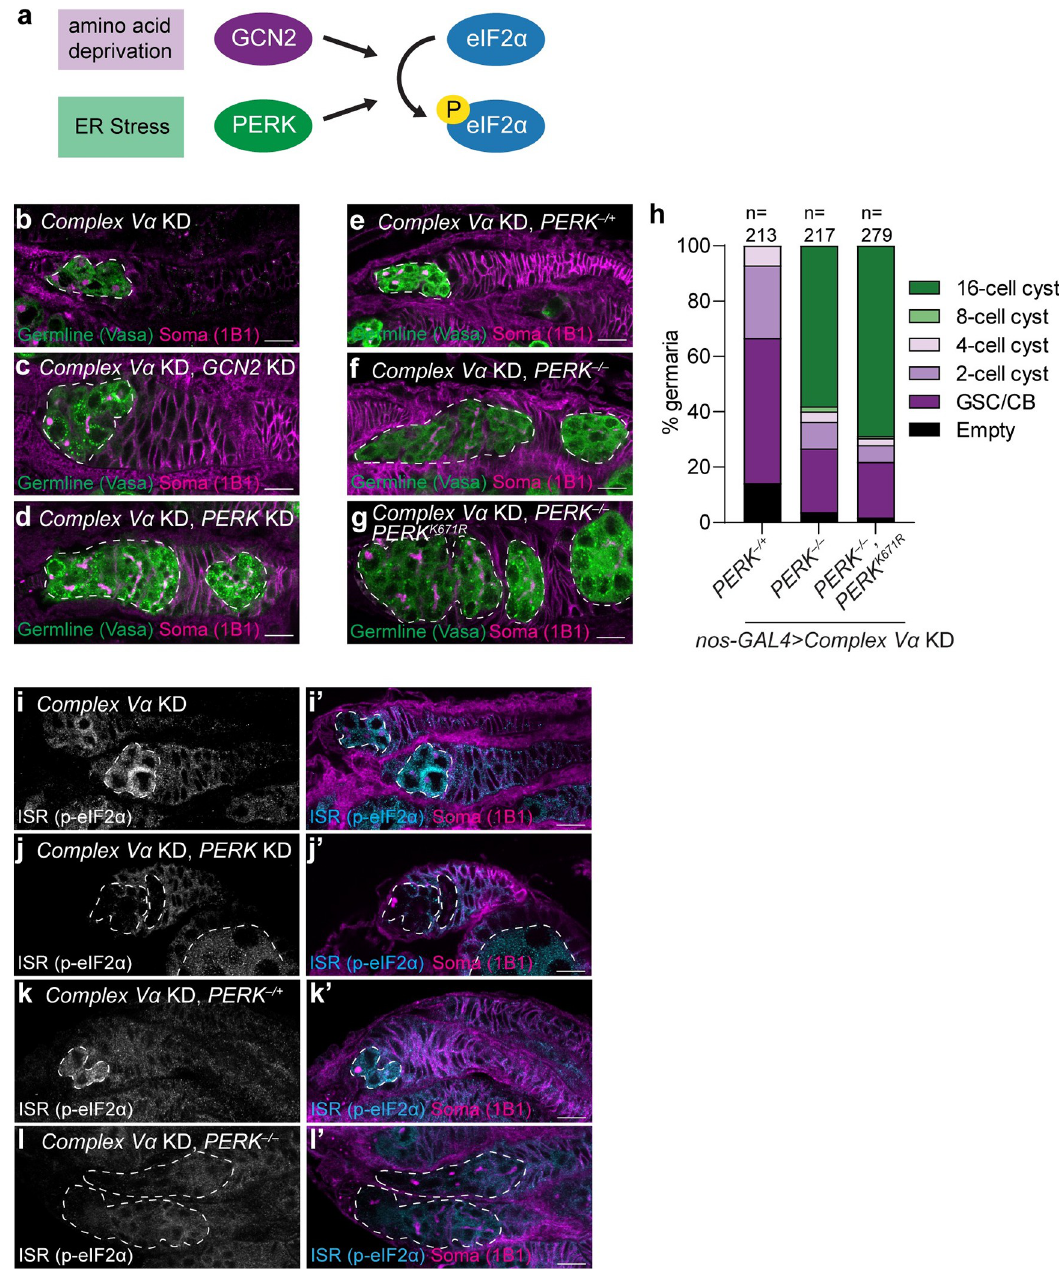
Fig 4. Complex V knockdown activates the Integrated Stress Response through PERK. (a) Schematic of Drosophila eIF2 α kinases. Amino acid deprivation or endoplasmic reticulum (ER) stress activate either GCN2 or PERK, respectively. Both kinases dimerize and phosphorylate eIF2 α . (b-d) Representative images of 2–3 day old CV α KD (b) , CV α , GCN2 KD (c) , and CV α , PERK KD (d) germaria. (e-g) Representative images of 1 day old CV α KD, PERK –/+ (e) , CV α KD, PERK –/– (f) , and CV α KD, PERK –/– , UAS-PERK K671R (g) germaria. (h) Phenotypic characterization and quantification of germline differentiation stage in germaria of (e-g) . Number of germaria scored above each bar and were studied from 10 or more ovaries, obtained in at least three independent experiments and over two or more crosses. (i-l) Representative images of 2–3 day old CV α KD (i) , CV α , PERK KD (j) , CV α KD, PERK –/+ (k) and CV α KD, PERK –/– (l) germaria. All RNAi were driven by nos-GAL4 . Images are representative of over 100 ovarioles and three independent experiments. Scale bars represent 10 μ m. White-dashed line indicates the germline cells. For exact genotypes see S2